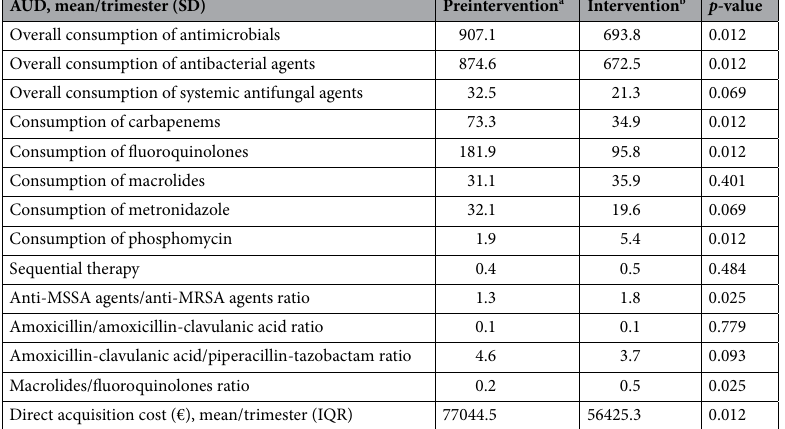
AUD, mean/trimester